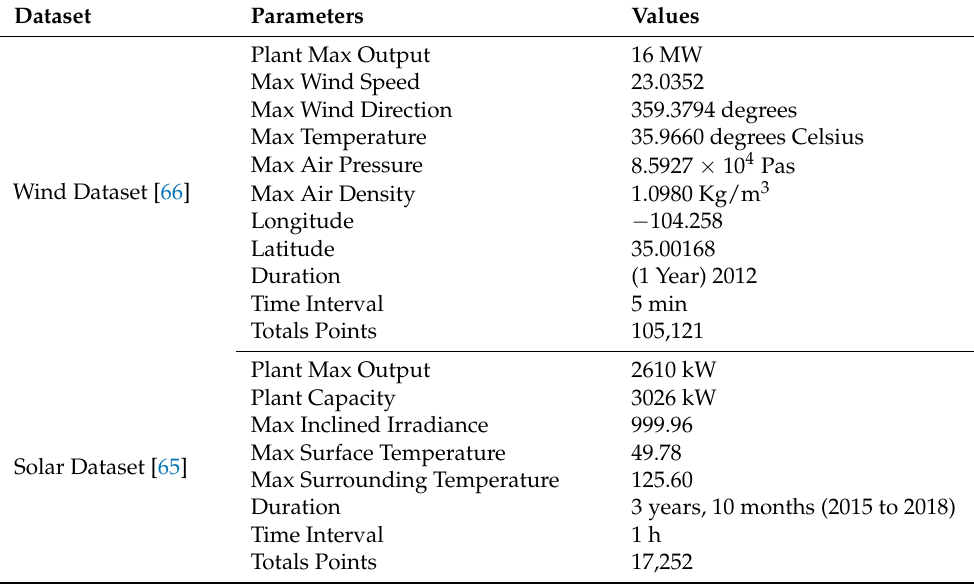
Table 1. Detailed description of each dataset along with its parameters and